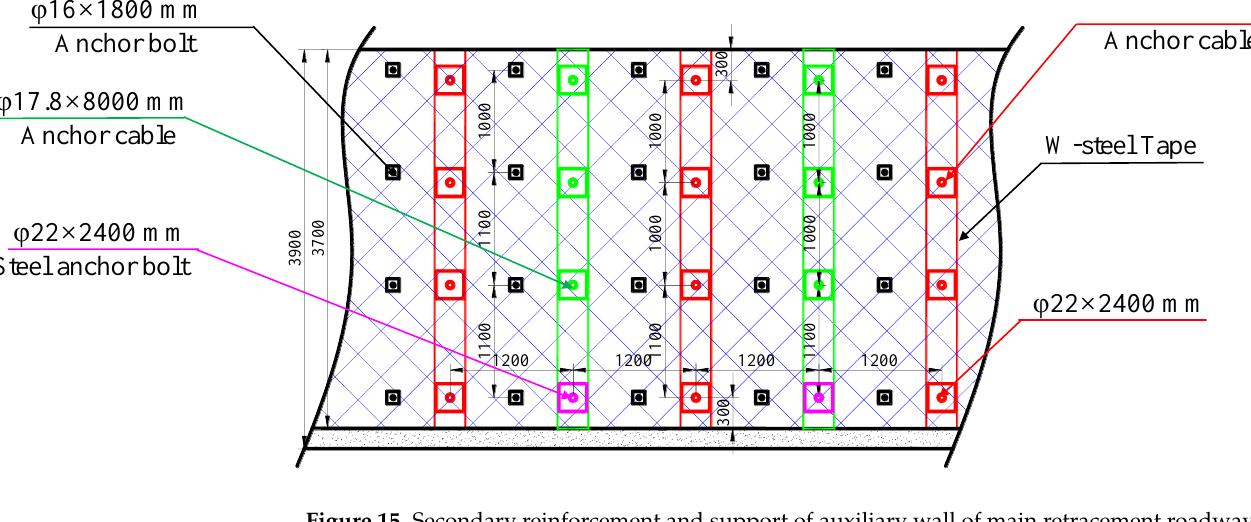
16 of 22 Figure 14. Schematic diagram of roof reinforcement and support of main retracement roadway. The auxiliary wall of the main retracement roadway is provided with support and secondary reinforcement. One group of the “ anchor cable + anchor bolt + steel tape ” com- bined support (shown in green in Figure 15) is built longitudinally and evenly spaced apart on the original support foundation. The main retracement roadway ’ s steel strip is 3.7 m long, with a row spacing of 2.4 m. The top three rows are anchor cable specifications,